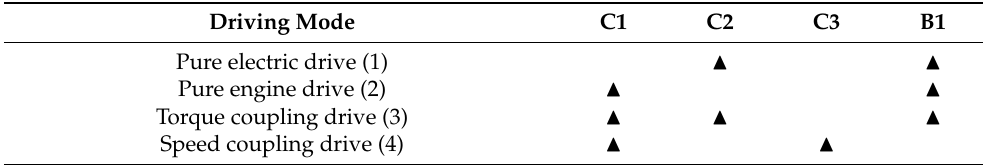
Table 1. Element engagement status of each driving mode.